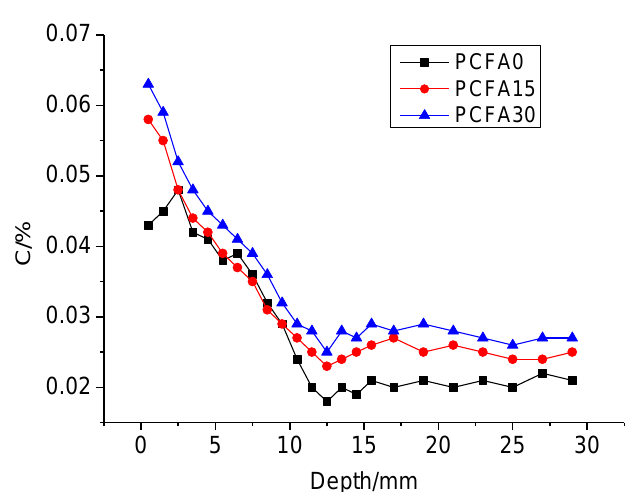
Figure 5. Distribution of total chloride, free chloride, and bound chloride in concrete samples (by mass%).